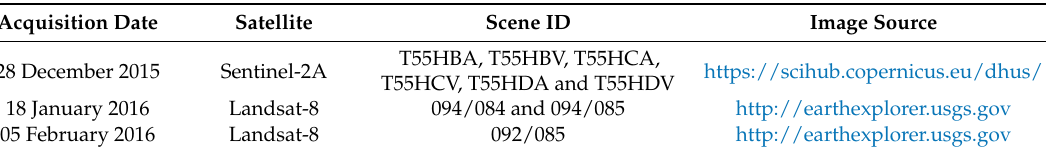
Table 1. Satellite data used in this study.